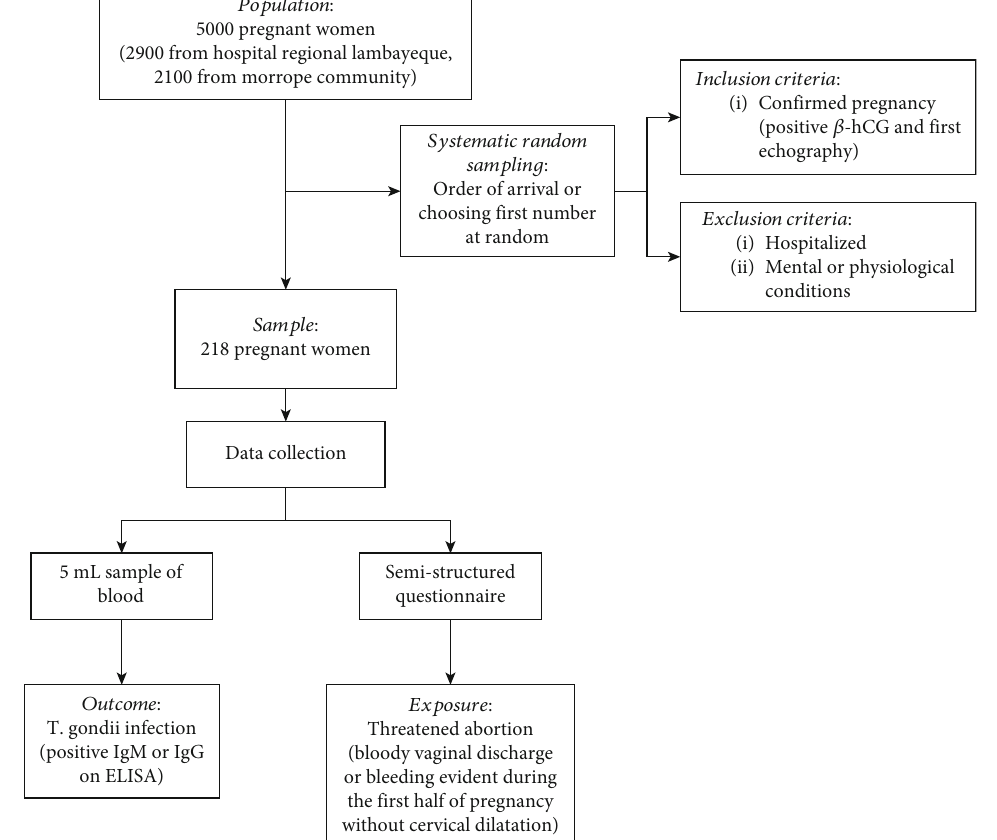
Figure 1: Flowchart of the data collection